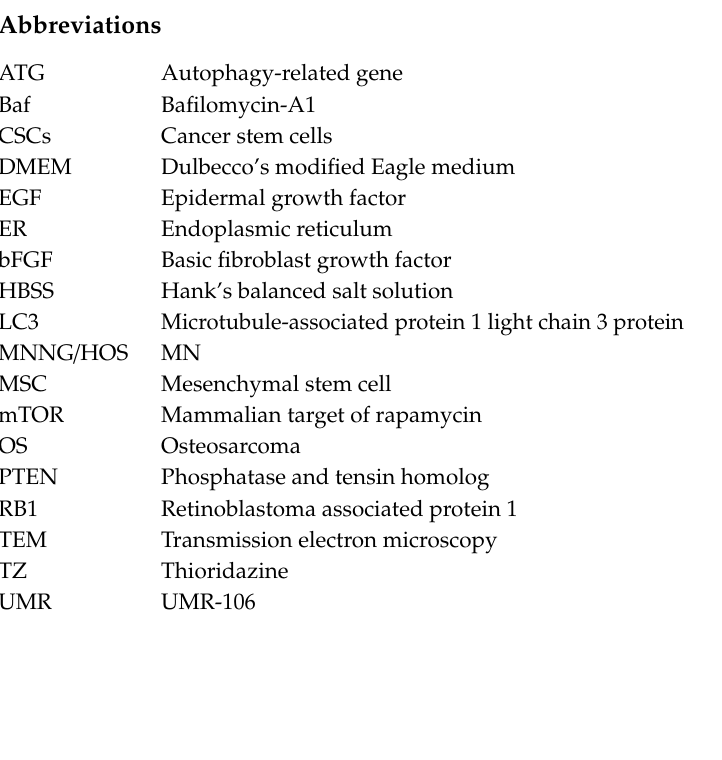
Figure S1: Di ff erentiation capabilities of the parental MN and UMR cells towards adipogenic and chondrogenic lineages, Figure S2: TEM analysis of the MN cell line and the corresponding spheres in control and starvation conditions, Figure S3: Comparison of the mortality rate in UMR and MN cell lines after 16 h in HBSS, Figure S4: TEM analysis of the UMR cell line and the corresponding spheres in control and starvation conditions, Figure S5: Original